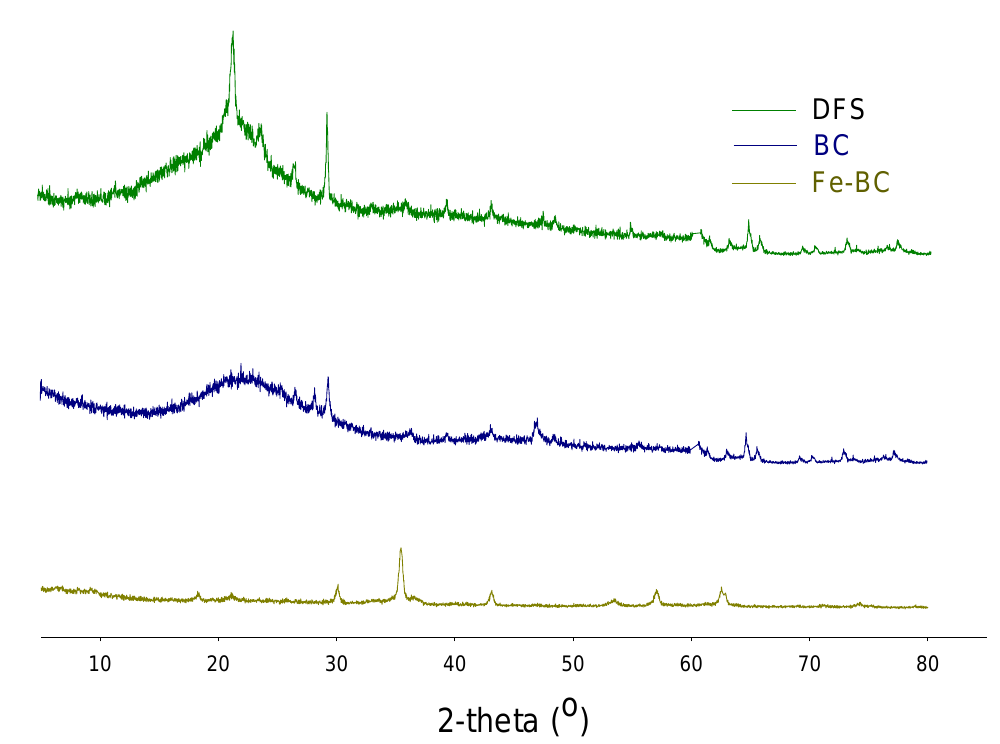
Figure 2. X-ray diffraction analysis of date palm waste (DFS), date palm waste biochar (BC), and Fe-modified biochar (Fe-BC).